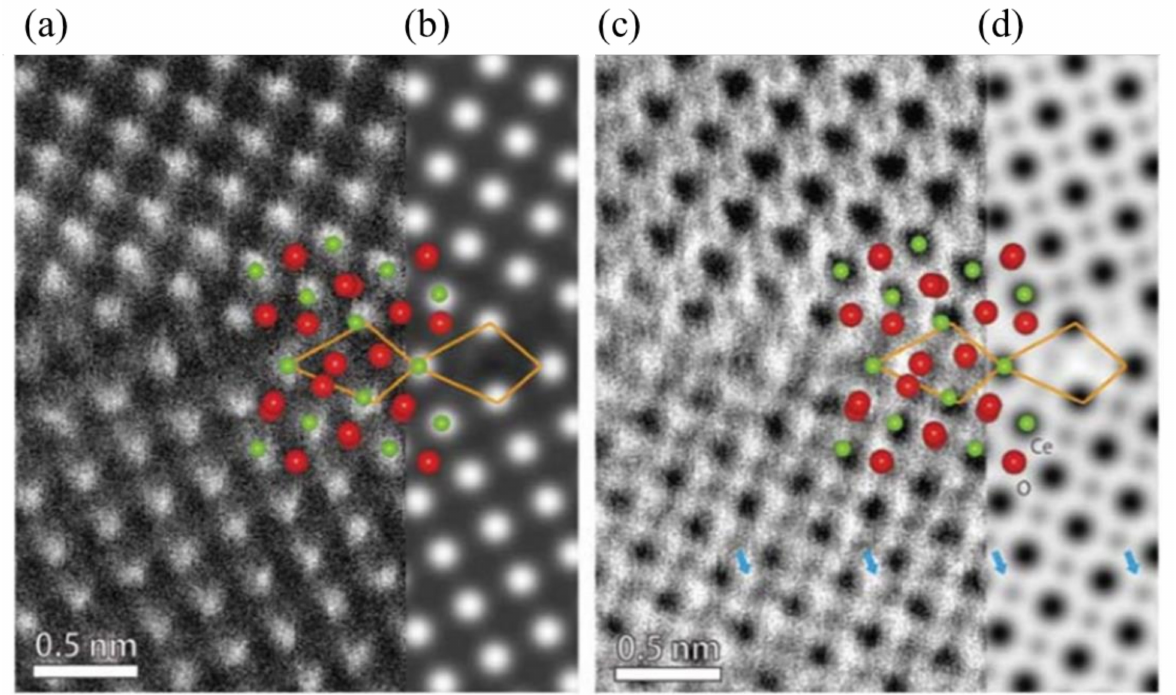
Figure 26. ( a ) HAADF, ( b ) simulated HAADF, ( c ) ABF image and ( d ) simulated ABF of a [001] (210) Σ 5 GB in a CeO 2 thin film. Simulated images are from a non-stoichiometric GB model structure. The structural units of each boundary are indicated by the polygons. A noise-reduction procedure was applied to the ABF image by a background subtraction filter [34]. The structural units of each boundary are indicated by polygons. Figure 26 reprinted with permission from Copyright © 2011, Oxford University